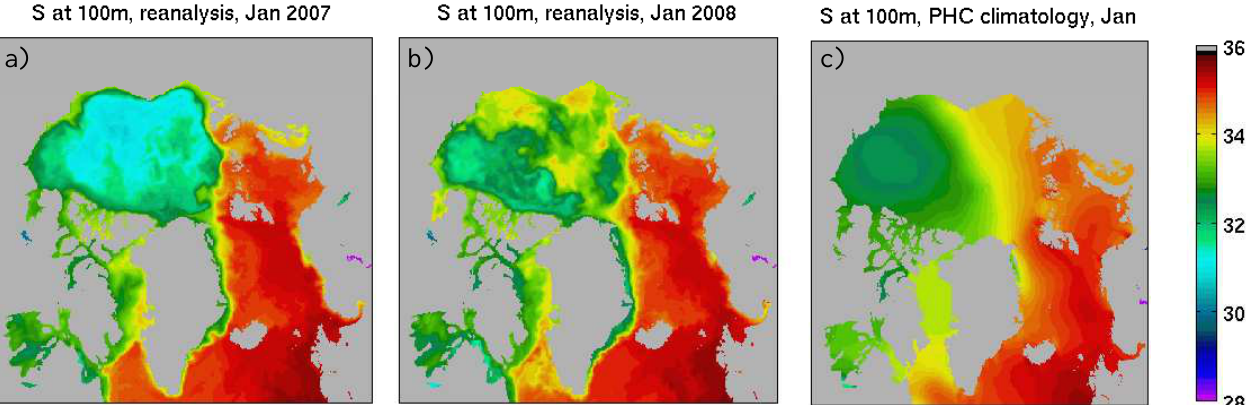
Fig. 15. Mean monthly salinity at 100m: (a) for January 2007 by TOPAZ4; for January 2008 by TOPAZ4; (c) for January from PHC